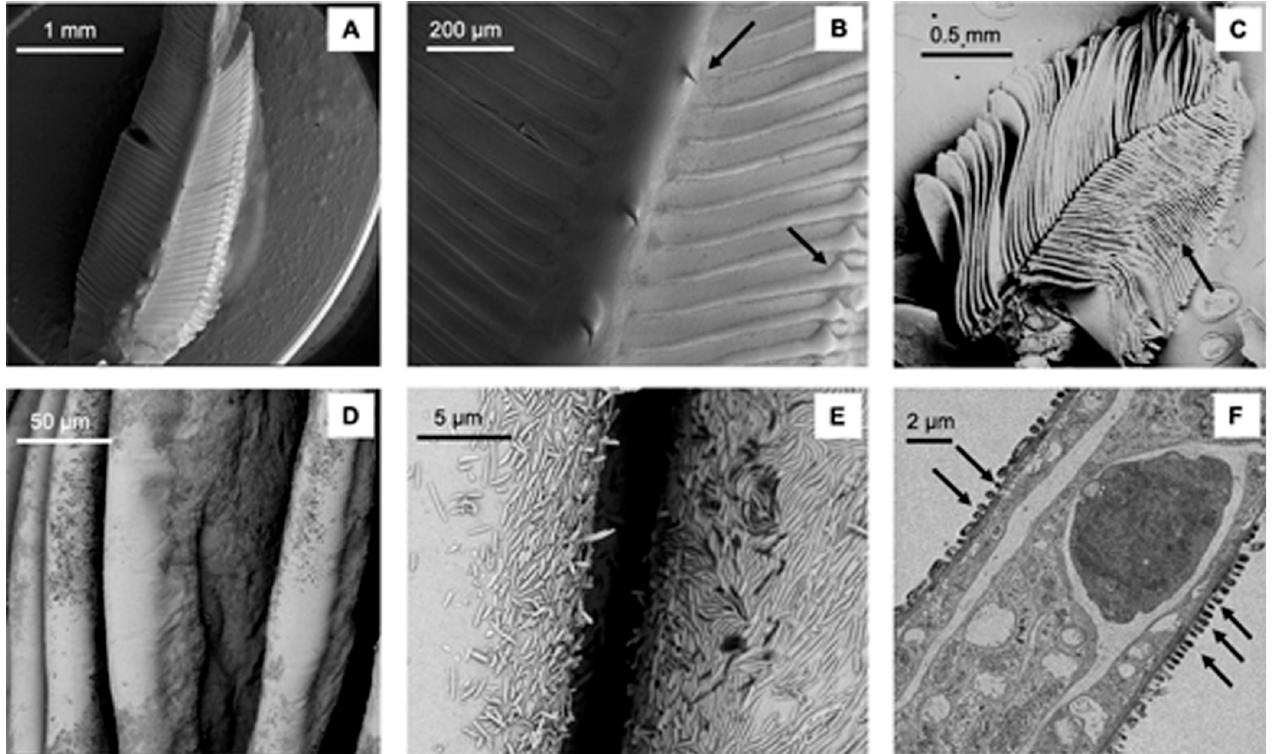
Fig 2. Gill structure morphology in the crab species Cranuca inversa . Image of a single gill observed with cryo-SEM at low magnification ( A ). Higher magnification showing gill lamellae connected by a membrane-like structure, black arrows indicate the preservation of the spine and bulb-like structures ( B ). Overview of the gill structure and lamellae organisation and the arrow shows the thicker part of the lamellae that prevent the collapse of the structure during emersion ( C ). Image of a single gill observed with conventional SEM at low magnification ( D ). Magnification of panel D showing separate gill lamellae covered by dark rough patches corresponding to bacterial coverage ( E ). Images of the bacterial community attached to the surface of the gill lamellae: Conventional SEM ( E ) and TEM—black arrows indicate the prokaryotic cells ( F ).